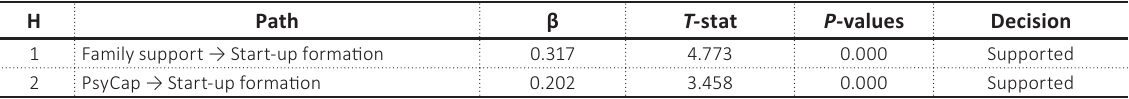
Table 2. Structural model estimates – main effects